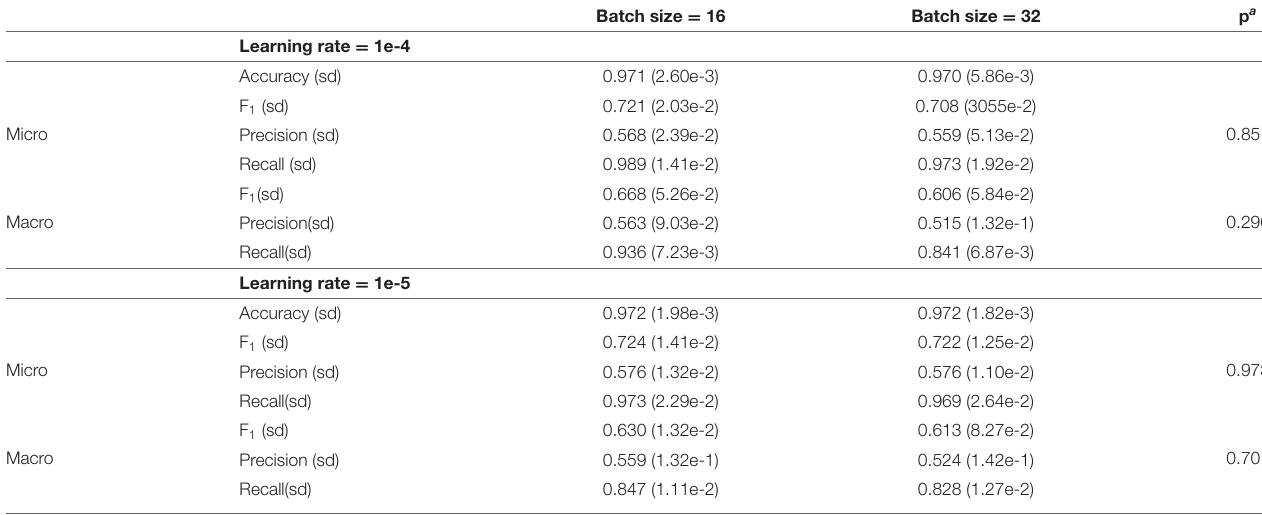
TABLE 2 | Performance measures of the model.